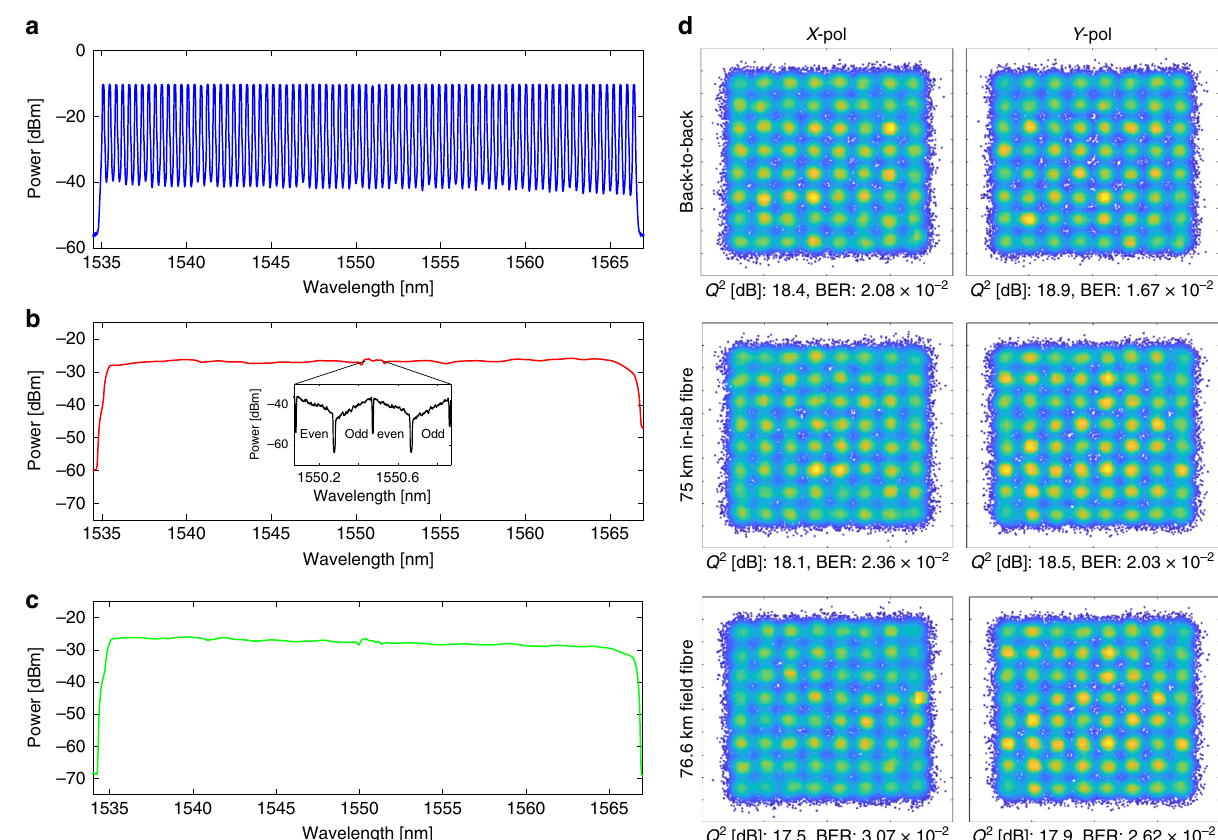
Fig. 3 Soliton crystal super-channel spectra, and indicative signal constellations. a – c Spectra of the soliton crystal frequency comb after fl attening a , modulation and transmission through either 75 km spooled in-lab fi bre b or through the fi eld-trial link c . The spectrum a is measured with 12.5 GHz resolution to resolve the individual comb lines, whereas b and c are plotted at 50 GHz resolution to illustrate average channel powers. Flattening equalised the comb line power to within 1 dB. After modulation and ampli fi cation, the channels were shaped by the EDFA gain spectrum. The inset in b depicts the test channel spectra captured with a 150 MHz resolution optical spectrum analyser (Finisar WaveAnalyzer), highlighting the odd and even sub-bands modulated onto each comb line in the test band. d Constellation diagrams for a comb line at 193.4 THz (1550.1 nm) for both X- and Y-polarisation channels. ‘ Back-to back ’ denotes the transmitter directly connected to the receiver, ’ 75 km in-lab fi bre ’ indicates reception after transmission through 75 km of spooled fi bre inside the lab (as per b ), whereas ’ 76.6 km fi eld fi bre ’ denotes reception after transmission through the fi eld-trial link (as per c ). BER and Q 2 related to the constellations are noted on